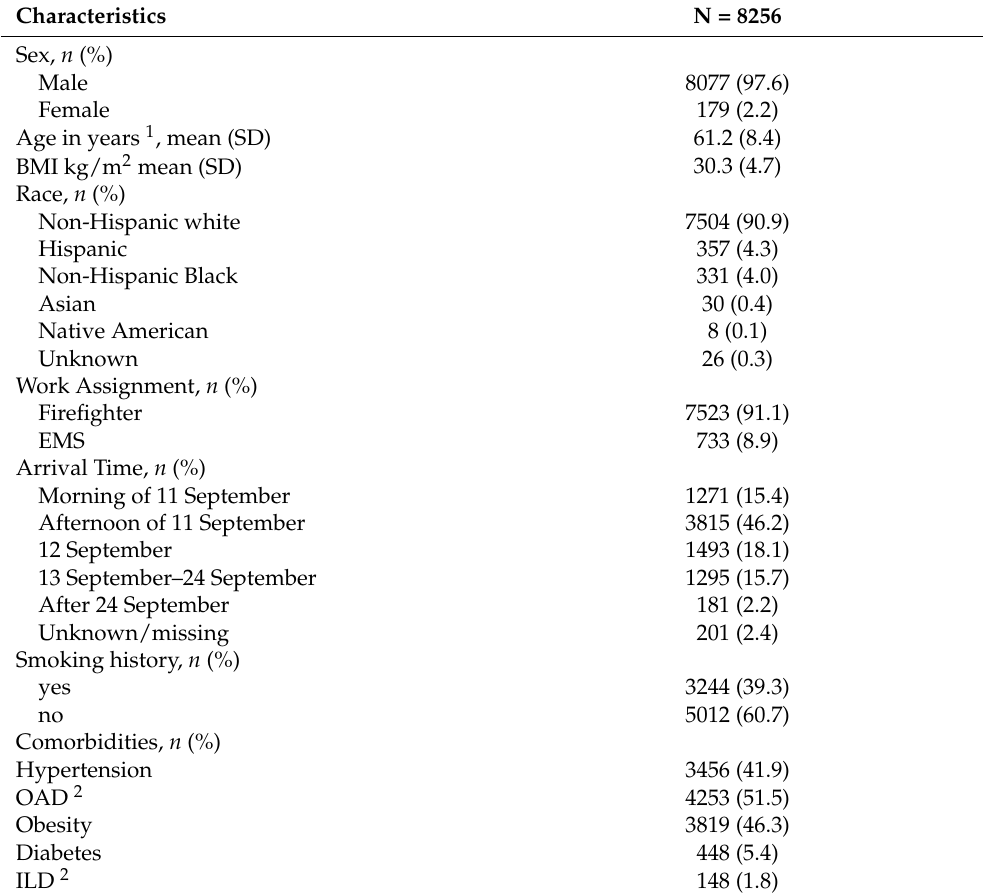
Table 1. Study Cohort